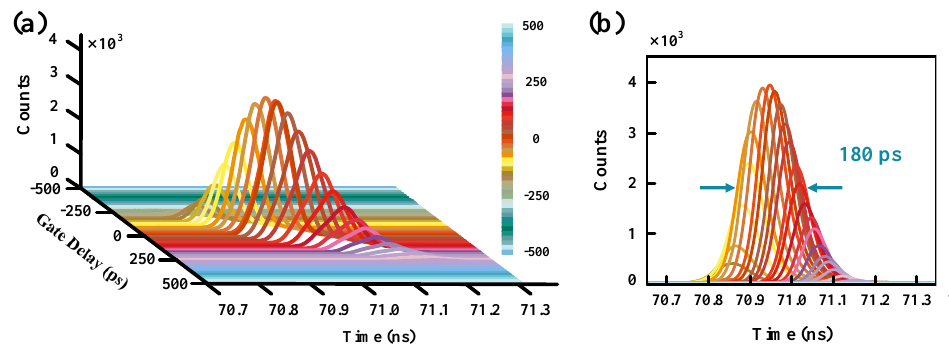
Figure 5. ( a ) Time distributions of the SPAD’s counts as a function of the delay between S SYN and S gate . ( b ) Accumulation time distributions with different S gate delay.